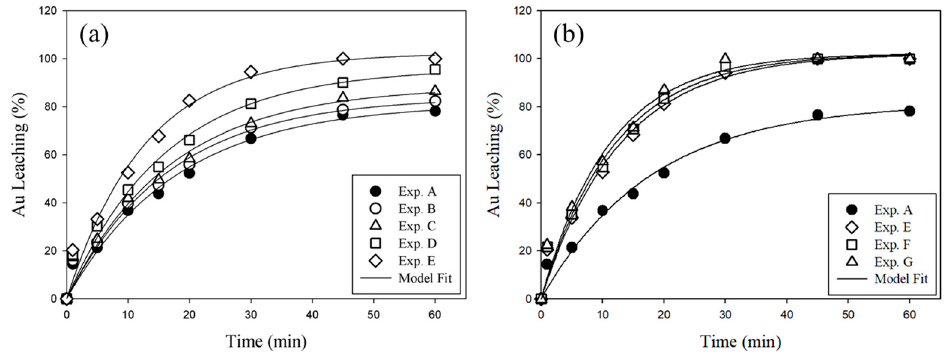
Figure 4. Gold recovery by leaching test under various conditions of ( a ) microwave pretreatment— irradiation time from 0 to 70 min and ( b ) lixiviant composition—thiourea concentration from 34.7 to 52.0 mM.